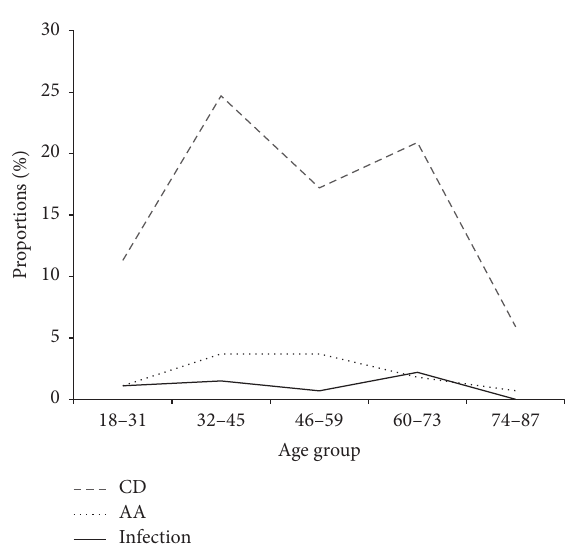
Figure 4: Acute and chronic clinical disease stratified into age groups. CD: chronic pathology (lymphedema, hydrocele, and lym- phedema combined with hydrocele); AA: acute attacks (filarial fever); infection: circulating filarial antigen